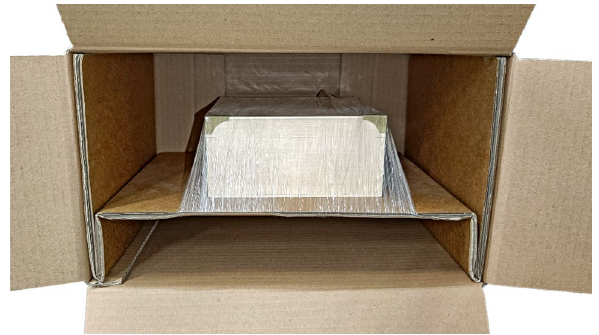
Fig. 2 Damage boundary curve, simplified region marked in